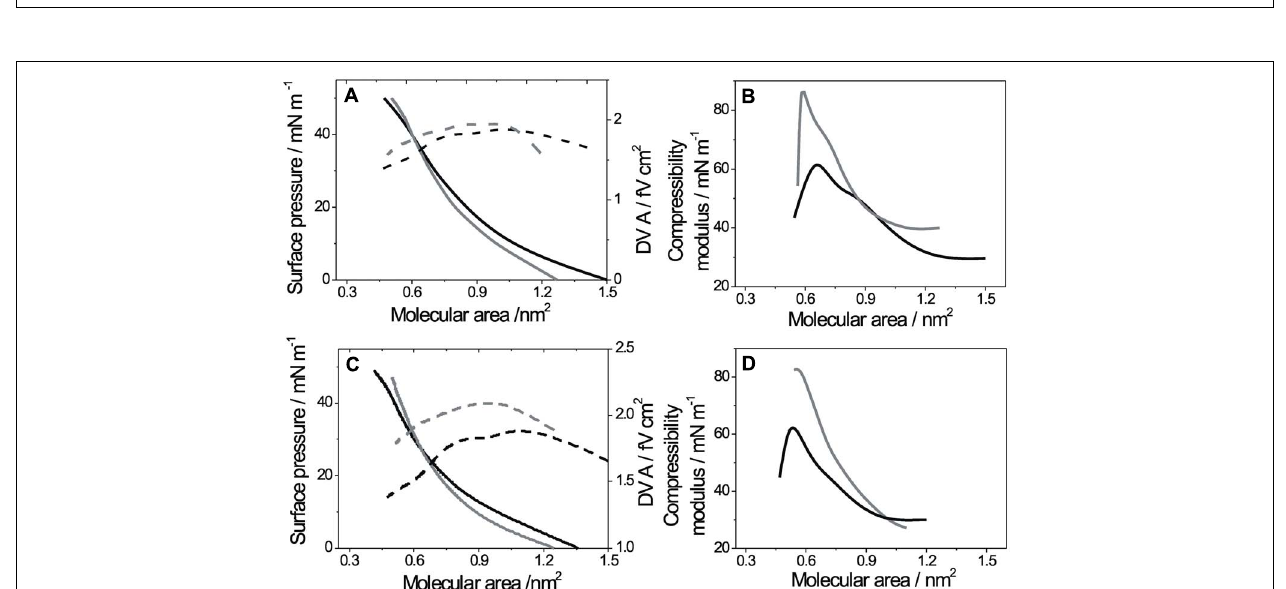
zoom for (cid:4) V · A of POPA on solutions with Zn 2 + (same as in the main plot). (D) Compressibility modulus for the isotherms shown in C . Insets: representative images for POPA films on solutions with Zn 2 + obtained with FM at the indicated lateral pressures. Real size: 100 μ m × 100 μ m. Subphase composition: 0.15 M NaCl + 5 mM EDTA, pH 5 (black lines) and 0.15 M NaCl, 5 mM EDTA + 8 mM ZnCl 2 , pH 5 (gray line). All curves show a single representative experiment from a set of triplicates.